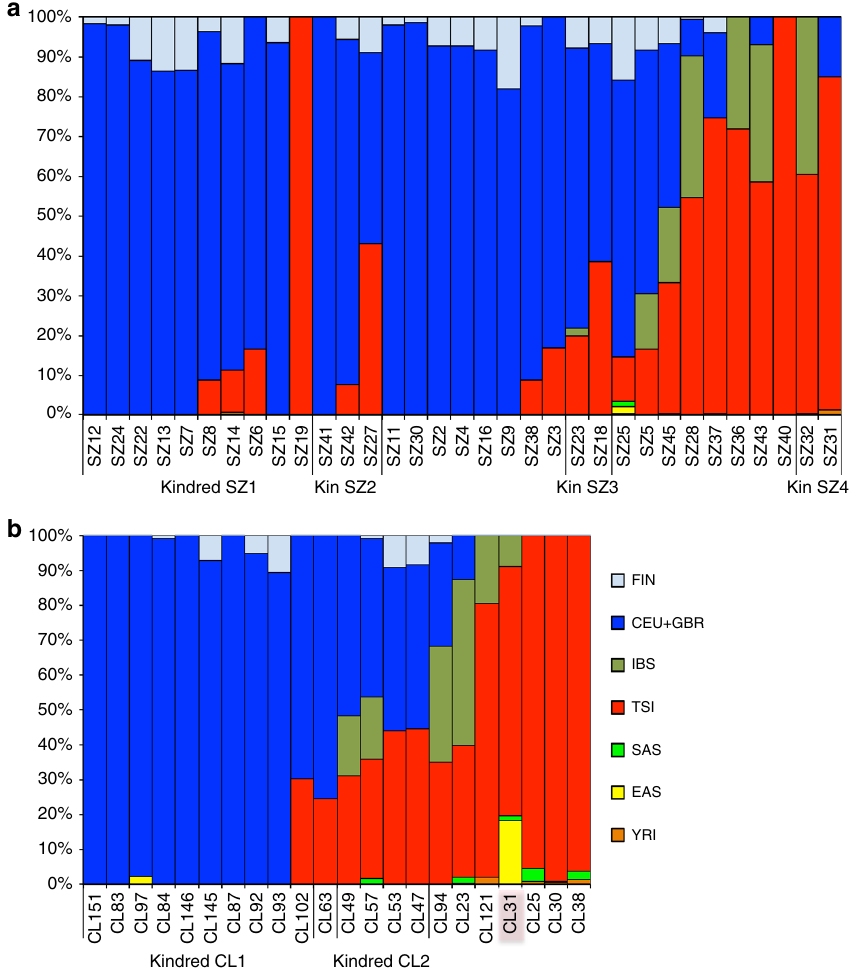
Fig. 3 Genetic structure of Szólád and Collegno. Model-based ancestry estimates from ADMIXTURE for Szólád ( a ) and Collegno ( b ) using 1000 Genomes Project Eurasian and YRI populations to supervise analysis. Note that high contamination was identi fi ed in CL31 and overlaid with a pink hue in